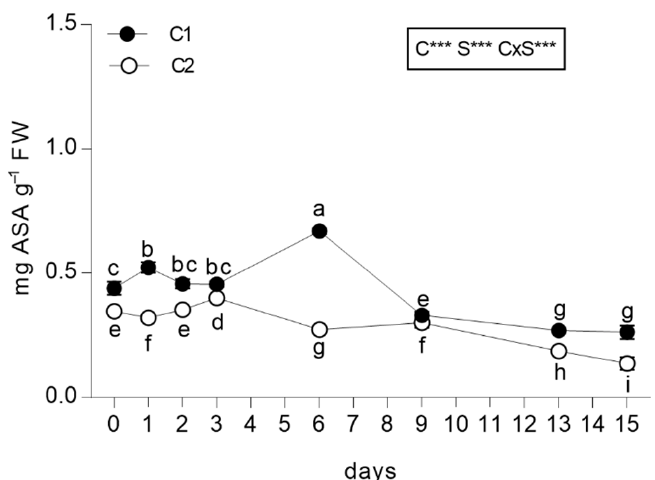
Figure 3. Ascorbic acid content of Rumex acetosa stored at 4 ◦ C for 15 days as fresh-cut products. Closed and open symbols represent first (C1) and second cut (C2) during the growth, respectively. Each value is the mean ( ± SD) of three replicates. Means having the same letter are not significantly different at p = 0.05 following two-way ANOVA with storage (S) and cut (C) as variables. F values for main effects and their interaction significant at p < 0.001 (***). Ascorbic acid content values were expressed as ascorbic acid (ASA) mg g –1 FW.